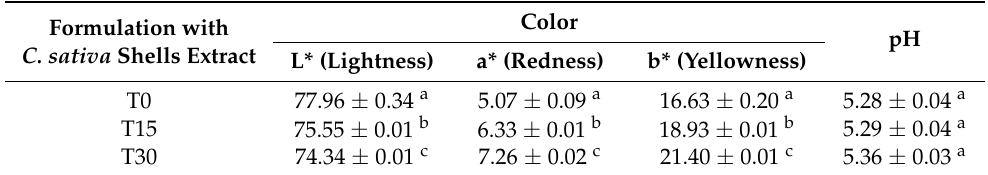
Table 4. Color (L*, a* and b*) and pH variation of semisolid formulation containing C. sativa shells extract evaluated at different storage times (mean ± standard deviation, n = 3). Formulation